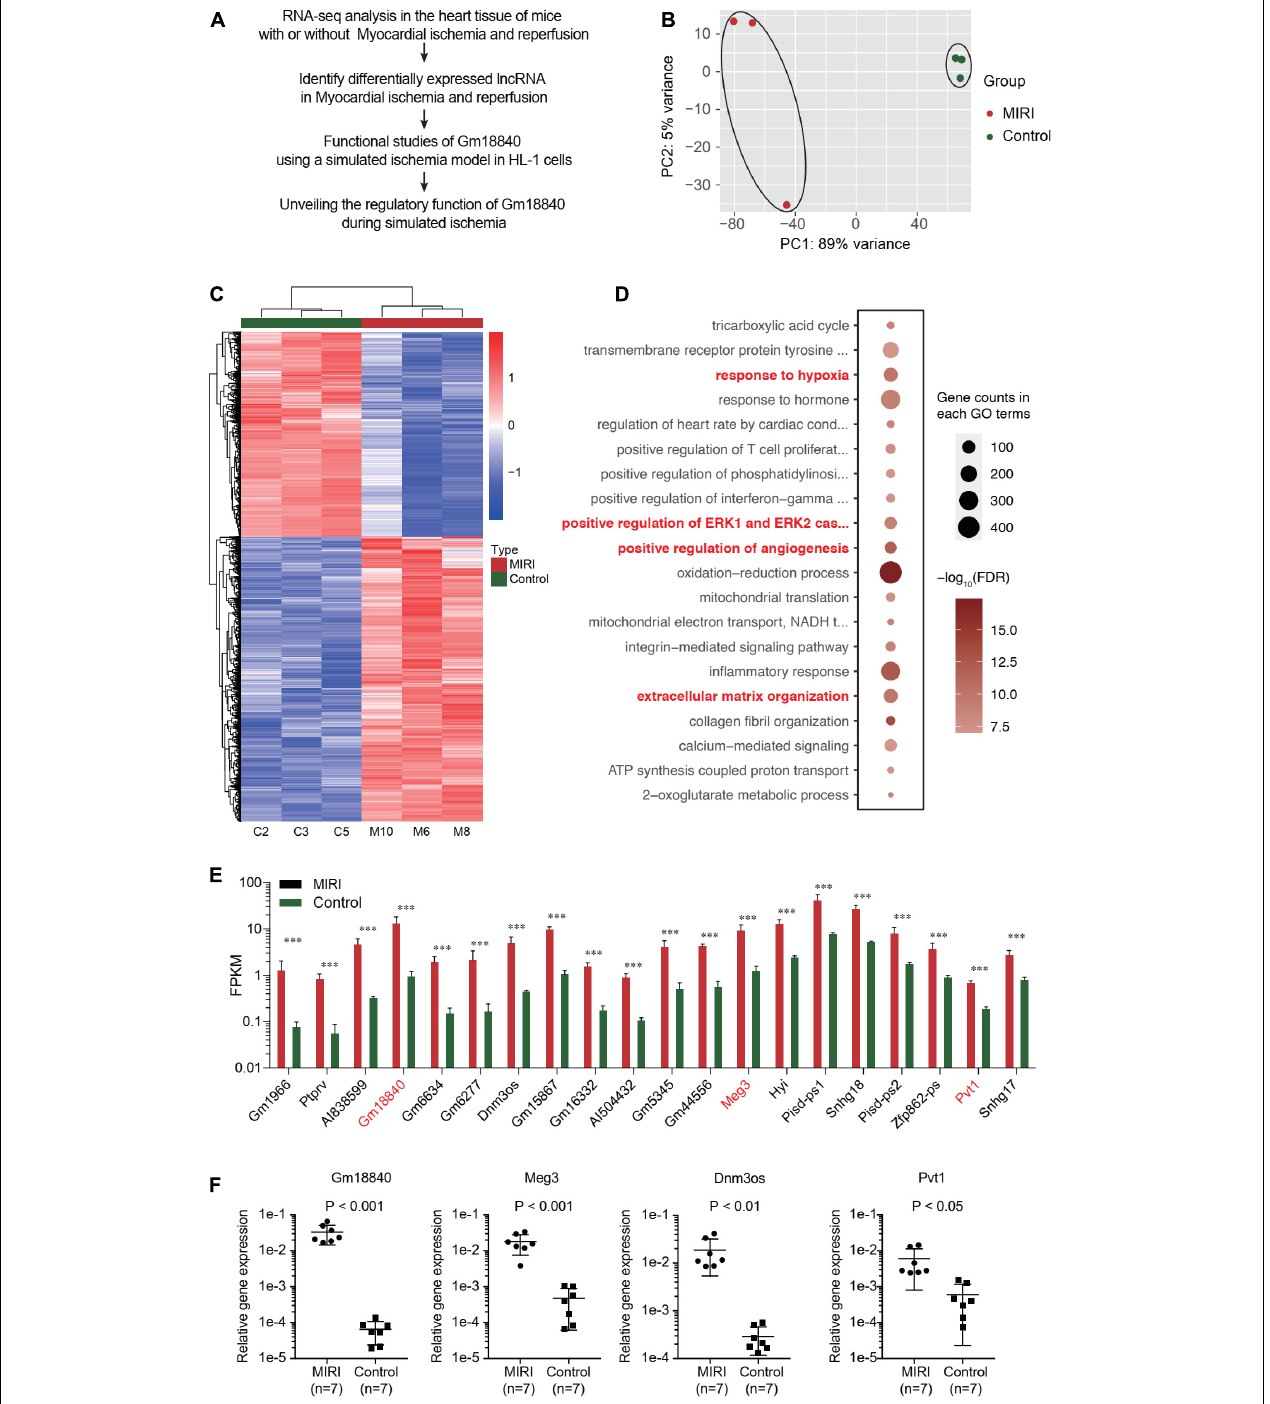
FIGURE 1 | Identify lncRNAs that are differentially expressed upon myocardial ischemia–reperfusion injury. (A) The workflow of experimental design. Overall view of myocardial ischemia–reperfusion injury-related lncRNA identification and functional and mechanistic analysis of Gm18840 in myocardial ischemia–reperfusion injury. (B) Distinct gene expression patterns in cardiac tissues with or without IRI treatment. PCA plot showing the clustering of the RNA expression profile of cardiac tissue in mice with or without IRI. The red dots represent the IRI samples, and the blue dots represent the normal samples. (C) Heatmap showing differentially expressed genes in cardiac tissues with or without IRI. Detailed differentially expressed genes are provided in Supplementary Tables 1, 2 ,. (D) Gene ontology analysis of differentially expressed genes in cardiac tissues with or without IRI treatment. (E) Illustration of differentially expressed lncRNAs in cardiac tissues upon IRI treatment. (F) Validation of the differentially expressed lncRNAs by qRT-PCR in cardiac tissues with or without IRI treatment. *** p < 0.001.